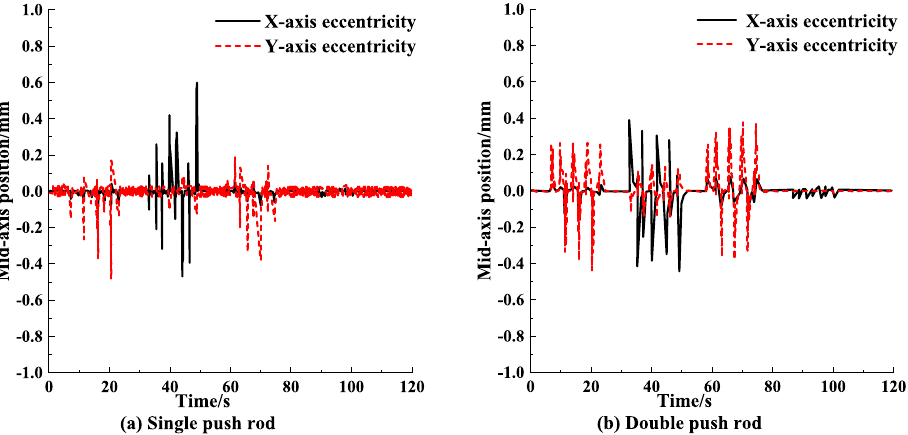
Figure 9. The displacement of the mid − axis of the single push rod support adjustment mechanism, double push rod − double spring support adjustment mechanism under casing wear